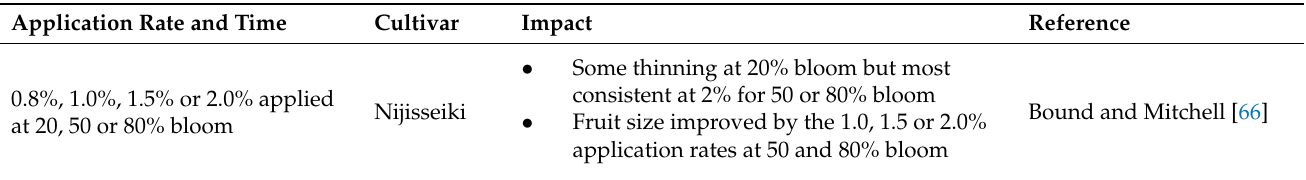
Table 7. Summary of the findings on the impact of ammonium thiosulphate (ATS) as a chemical thinning agent for